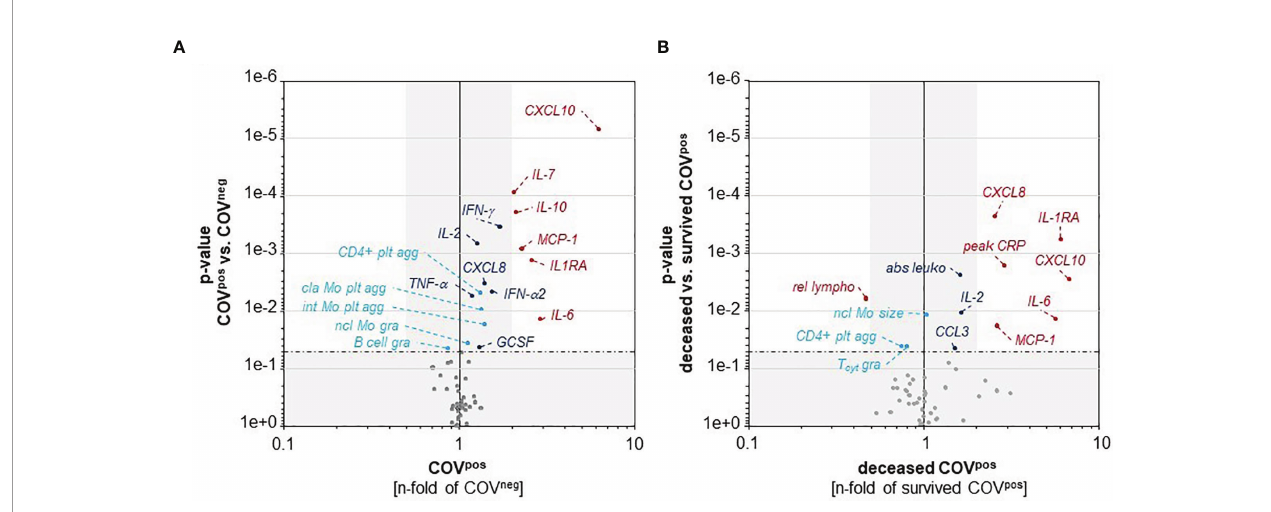
FIGURE 4 | CXCL10, IL-6, MCP-1, and IL-1RA are higher in COV pos than in COV neg patients (A) and also higher in deceased than in surviving COV pos patients (B) . A higher percentage of classical and intermediate monocytes and CD4 pos T H lymphocytes form aggregates with platelets in COV pos than in COV neg patients (A) . Deceased COV pos patients showed lower relative abundance of lymphocytes and higher total leukocyte counts than surviving COV pos patients (B) . p -value of 0.05 is indicated by the horizontal dashed-dotted line. p -values higher than 0.05 and less-than-twofold changes between groups are underlaid in grey. plt agg, platelet aggregates; gra, granularity; cla Mo, classical monocytes; int Mo, intermediate monocytes; ncl Mo, nonlassical